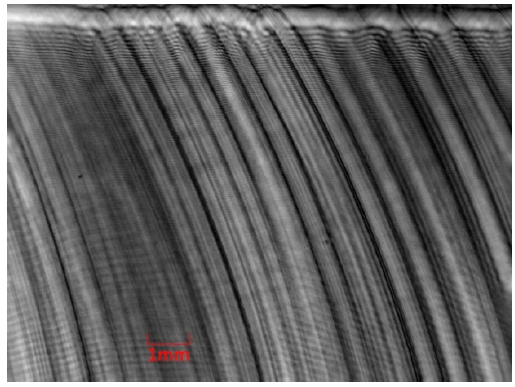
Figure 5. Growth striaes detected by the method of digital holography (restored image of the ZnGeP 2 plate cut parallel to the growth direction of the crystal plane located at a depth of 3 mm from the plate surface).